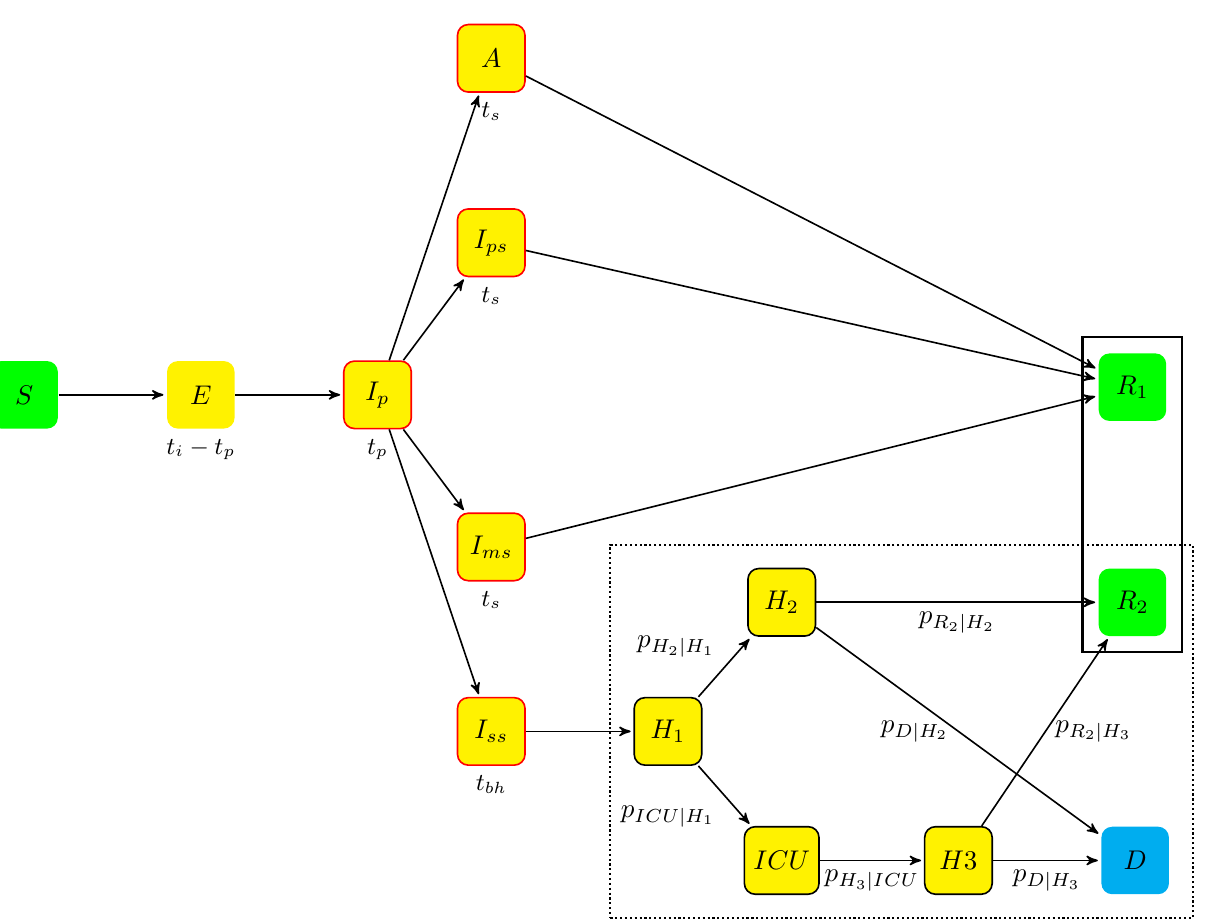
Figure 4. The states and their connections in the model. The left-hand part of the model represents the disease spreading with the average sojourn time beneath each compartment. The right-hand part of the model (bottom-right dotted frame) represents the hospitalized cases and their outcomes. It is composed of states H 1 , H 2 , H 3 , ICU , R 2 , and D . Each arrow is labeled with the individual daily transition probability between two states. Table 6. Estimated parameters (the values in italics for the left-hand part of the model are extracted from a previous work